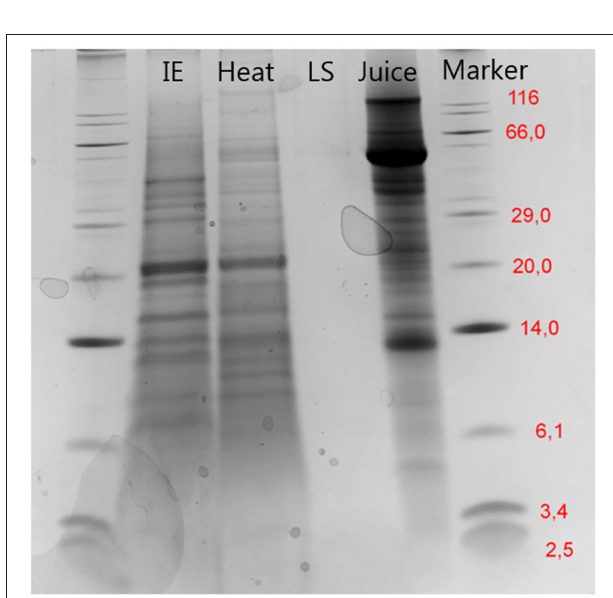
FIGURE 3 | SDS-PAGE analysis of the brown juices after precipitation of protein from spinach juice. LS is lignosulfonates. Thirty microliter sample was loaded for lignosulfonates, heat and acid. In the case of juice, 4 µ L sample was loaded. The numbers in red indicate the size of proteins in kDa.